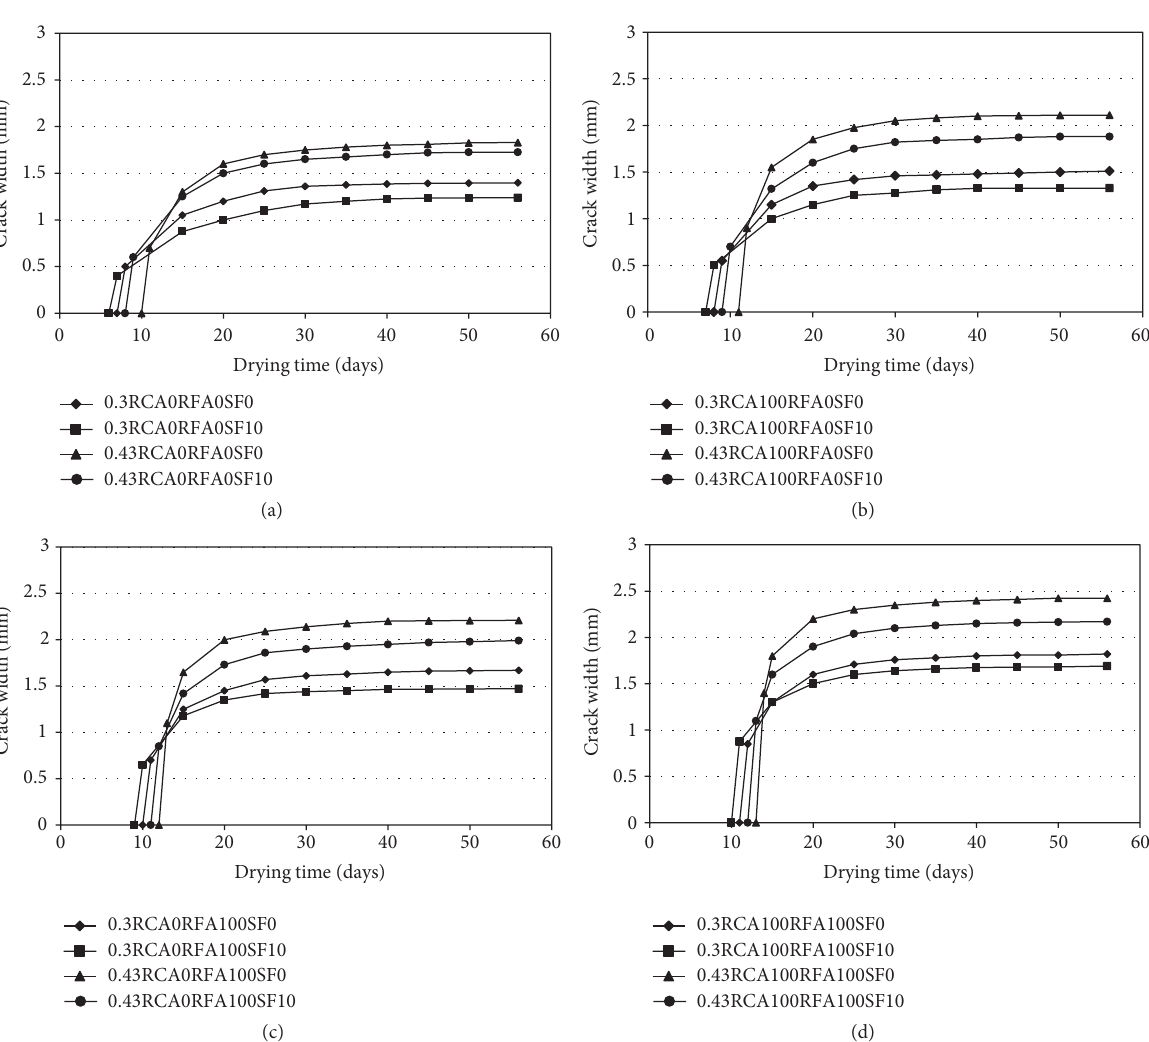
Figure 15: Restrained shrinkage for SCCs according to type of aggregate: (a) NAs (Series I), (b) RCA (Series II), (c) RFA (Series III), and (d) RAs (Series